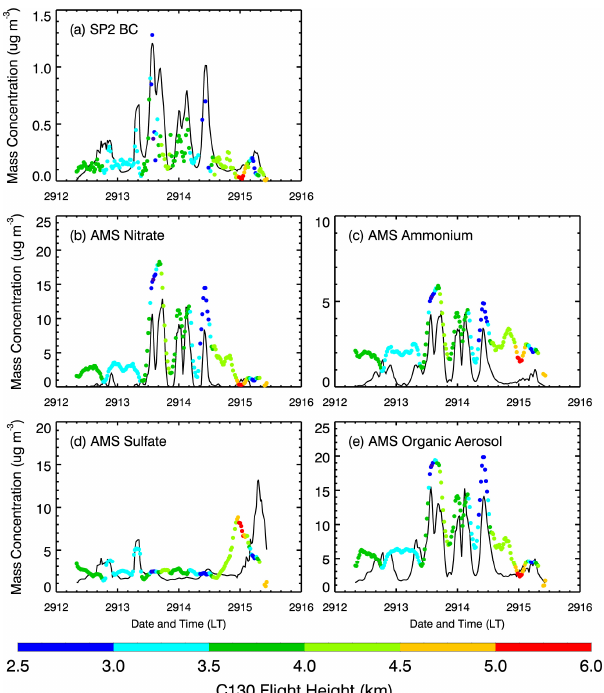
Fig. 3. Comparison of G-1 aircraft measured (dots with different colors) and simulated (black line) nitrate, ammonium, and sulfate aerosols along the flight tracks on 26 and 27 March . See Fig. 2 for the x-axis labels.